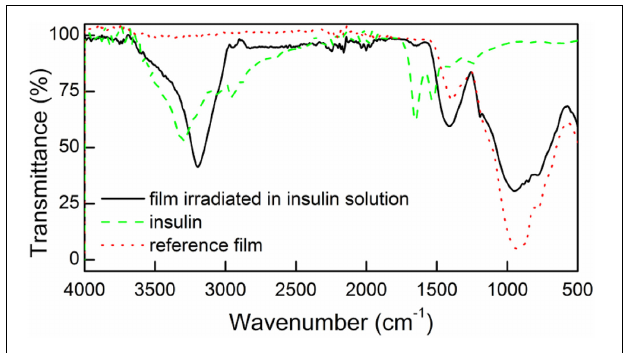
FIGURE 2 | FTIR spectra for the surfaces irradiated in the presence of insulin (DR/Pec/Ins, solid line), in the absence of insulin (DR/Pec, dotted line), and the spectrum of pure solid insulin (dashed line).